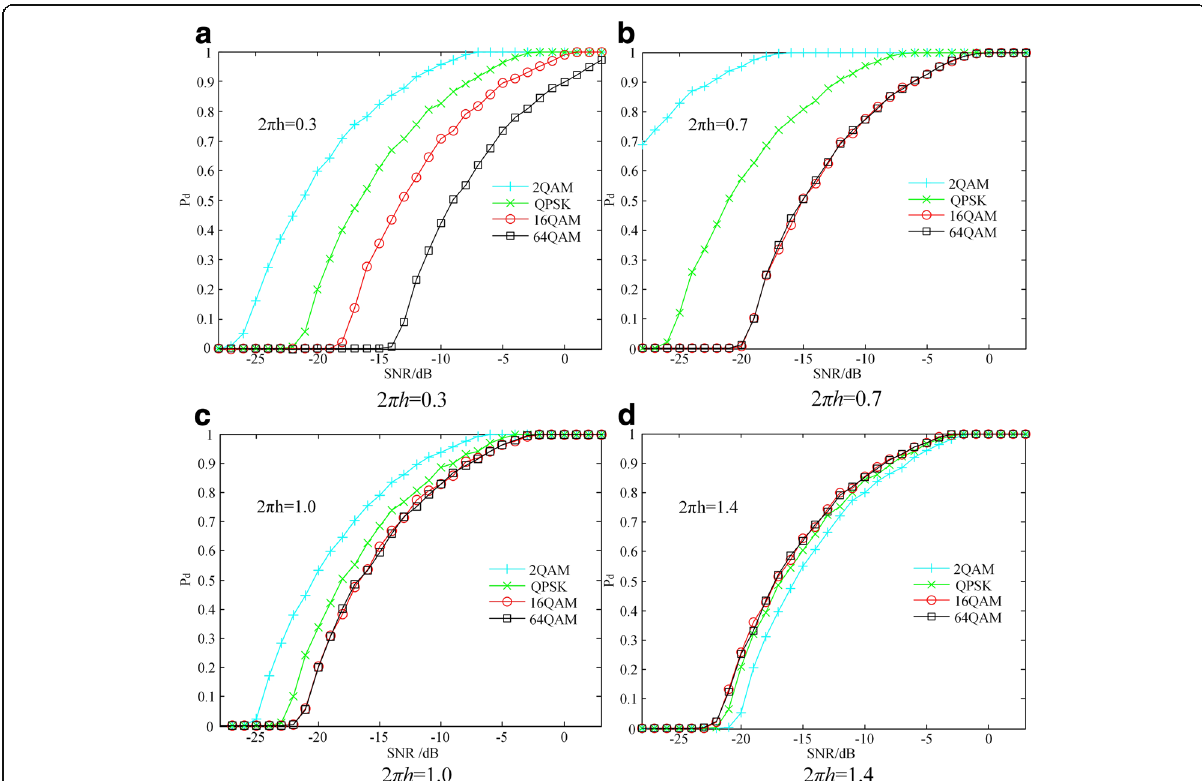
Fig. 12 The detection probability of CE-OFDM RadCom system for different MQAM and 2 π h. Detailed legend: with 0.001 false alarm probability, the threshold data in Fig. 11 is used to simulate the detection probability for the CE-OFDM RadCom system. The lines with the plus sign, cross, circle, and square represent 2QAM, QPSK, 16QAM, and 64QAM being used to produce the CE-OFDM RadCom signals, respectively. The 2 π h is dif- ferent. a 2 π h = 0.3, b 2 π h = 0.7, c 2 π h = 1.0, d 2 π h =